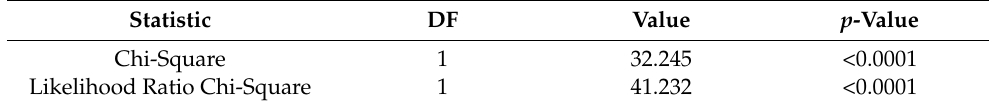
Table 4. Association between age and cancer status.